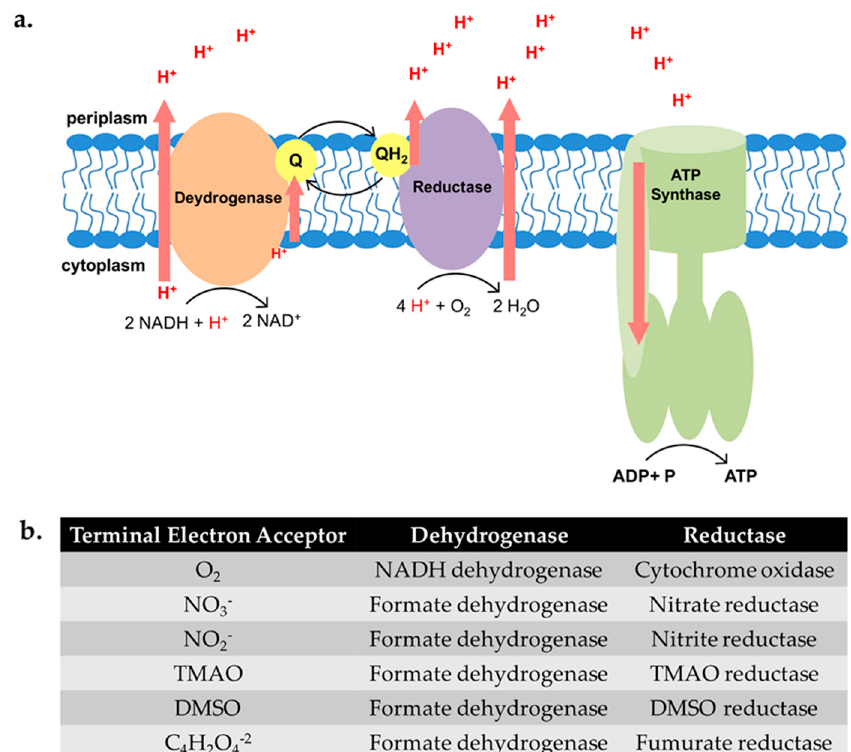
Figure 1. Schematic depicting critical enzymes in the electron transport chain. ( a ) The schematic represents the enzymes utilized to generate energy when oxygen is the terminal electron acceptor.